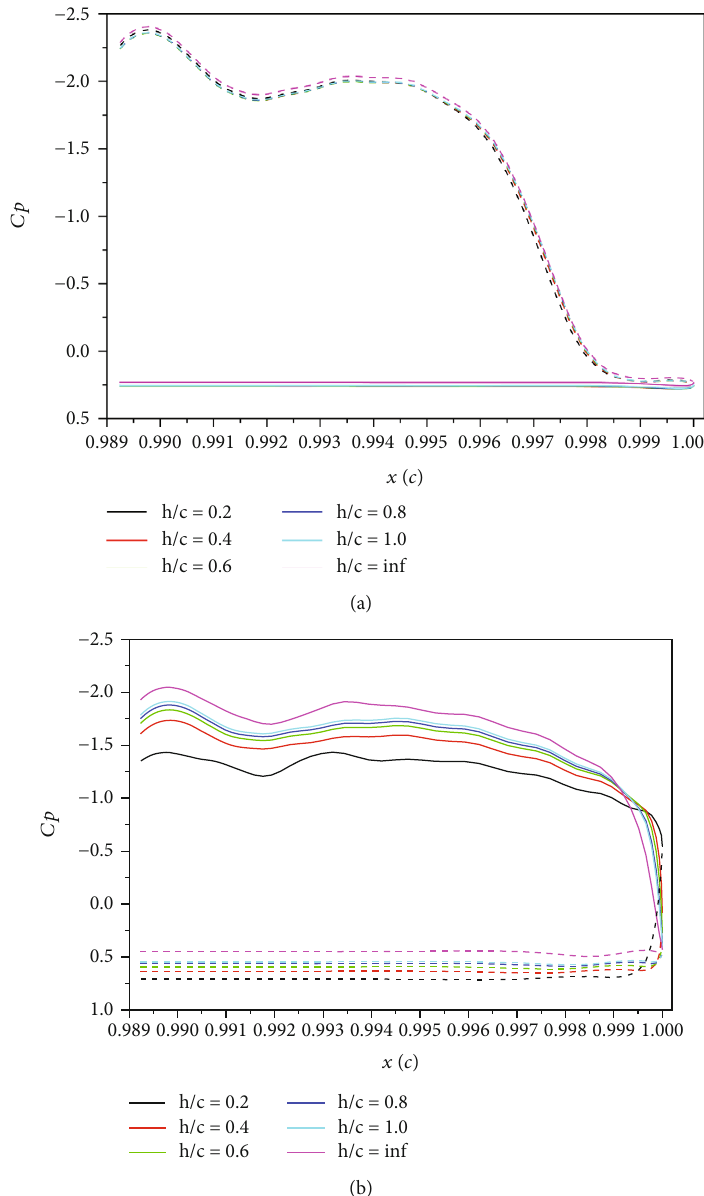
= − 0 : 013 ; (b) with C = 0 : 013 μ μ